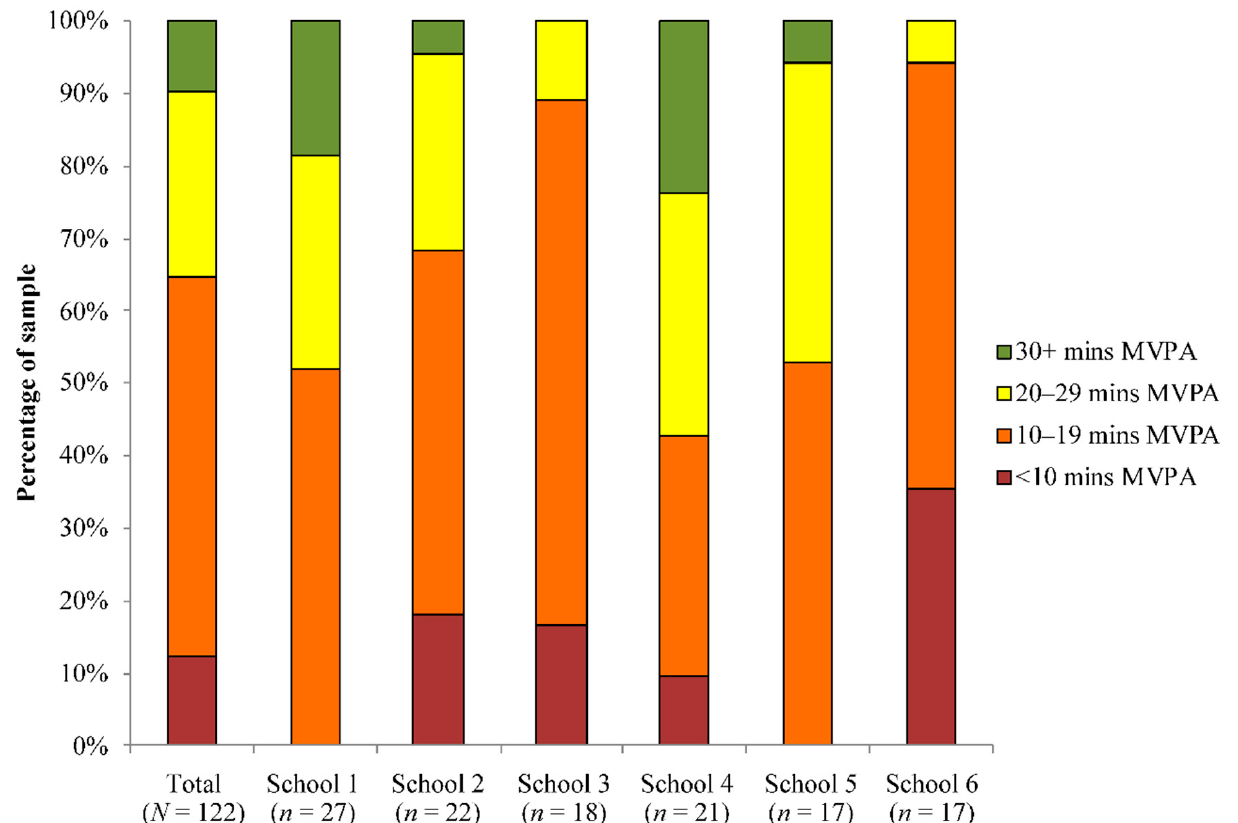
Figure 1. Differences between schools in the proportion of pupils who achieve 0–9 min, 10–19 min, 20–29 min and 30 + min of in-school moderate-to-vigorous physical activity per day; MVPA—moderate-to-vigorous physical activity.